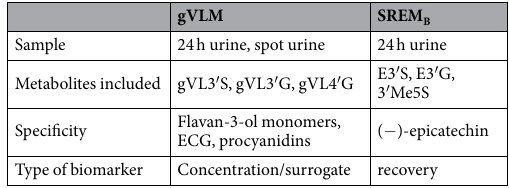
Table 4. Comparison of gVLM and SREM B as